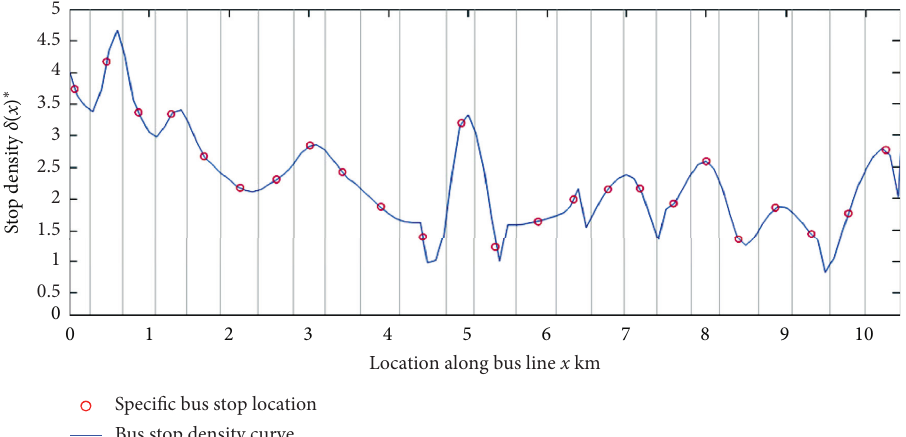
Figure 1: Example of the optimal stop density function δ ( x ) ∗ (source: Medina et al. [18]).